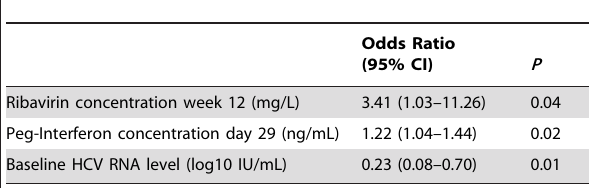
Table 2. Multivariate logistic regression to identify factors predictive of achieving SVR among per-protocol patients treated for 24